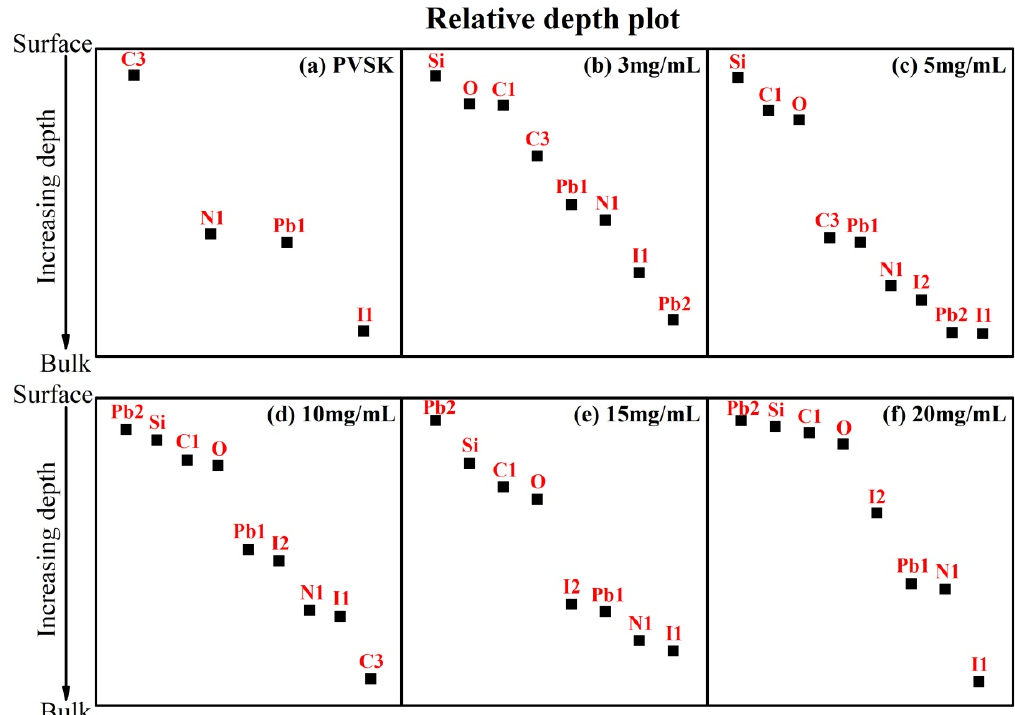
Figure 4. Relative depth plot of the chemical components of perovskite films fabricated with different concentrations of NH 2 -POSS.